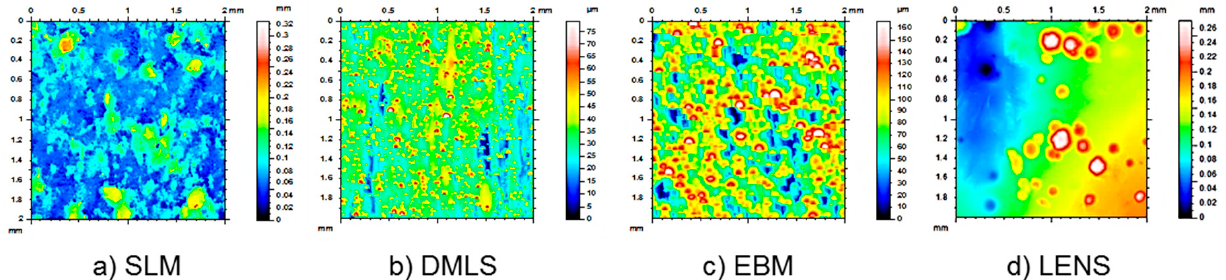
Figure 7. Leveled surface topography of as-built AM components. ( a ) SLM; ( b ) DMLS; ( c ) EBM; ( d ) LENS.